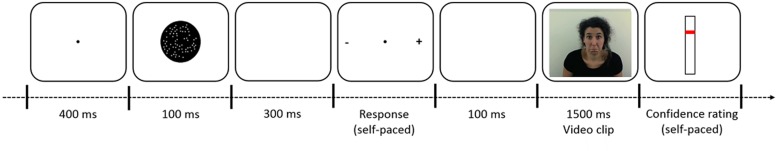
Time course of an experimental trial.